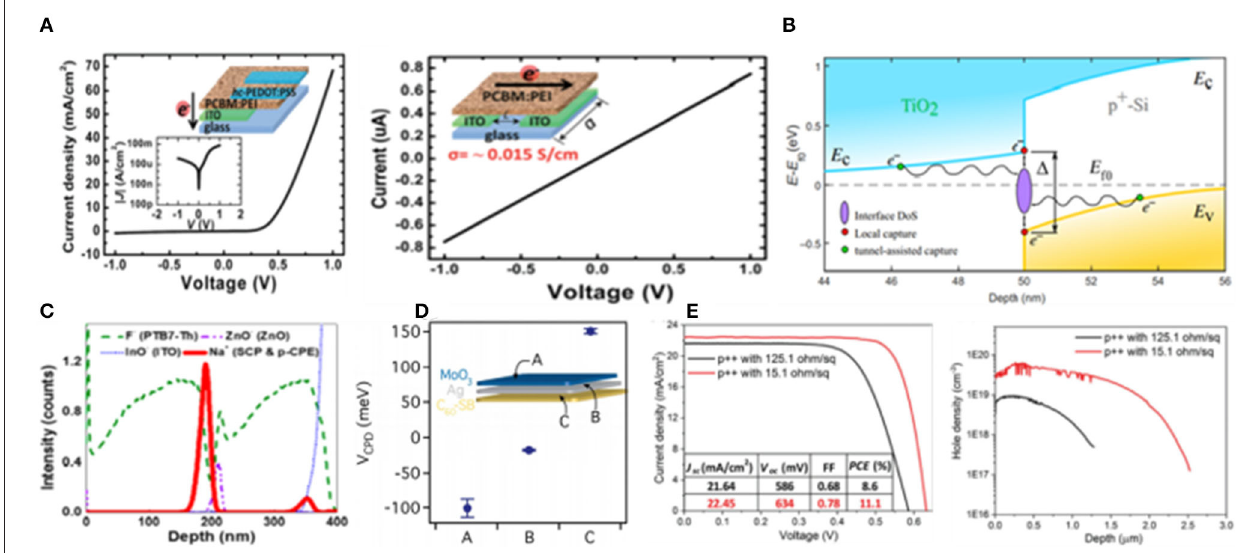
FIGURE 9 | (A) J–V characteristics of the devices including the current flows vertically across the film and the current flows in parallel with the substrate (reproduced from ref. 74, copyright 2016, The Royal Society of Chemistry). (B) Contact behavior and simulated band diagram of TiO 2 /p + -Si interfaces (reproduced from ref. 76, copyright 2018, Science Advances). (C) TOF-SIMS depth profile of the ITO/p-CPE:BHJ/ZnO/SCP/p − CPE:BHJ structure (reproduced from ref. 58, copyright 2016, ACS). (D) Surface potential (VCPD) of the recombination layers [C60-SB (30nm)/Ultrathin Ag (10nm)/MoO 3 (10nm)] (reproduced from ref. 75, copyright 2016,